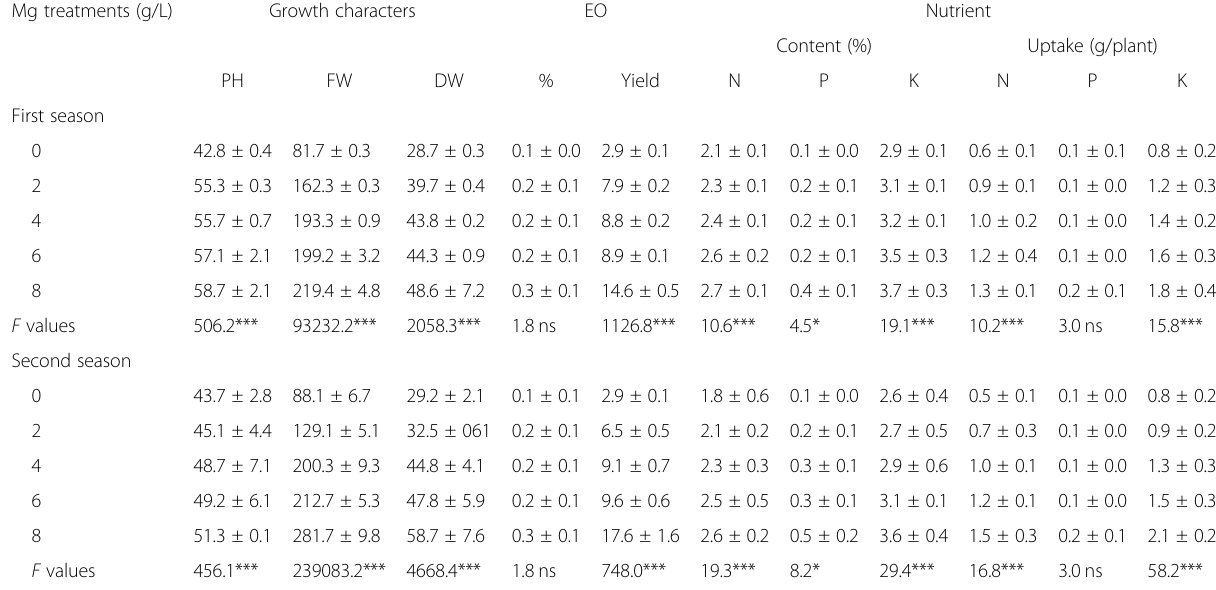
Table 3 Effect of Mg treatments on growth and chemical content Mg treatments (g/L) Growth